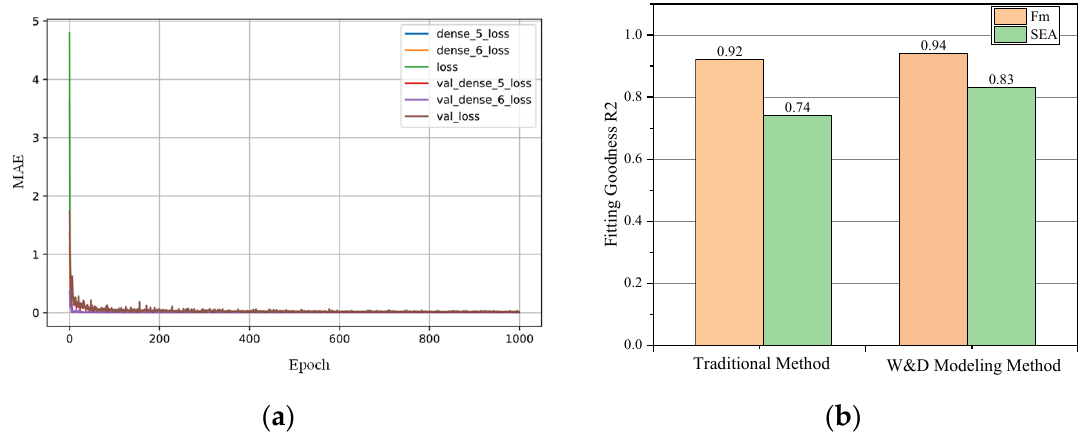
Figure 9. Training procedure: ( a ) loss curves on epochs; ( b ) fitting goodness R 2 . Figure 9 clearly indicates that both the few-shot learning model and the RBF model